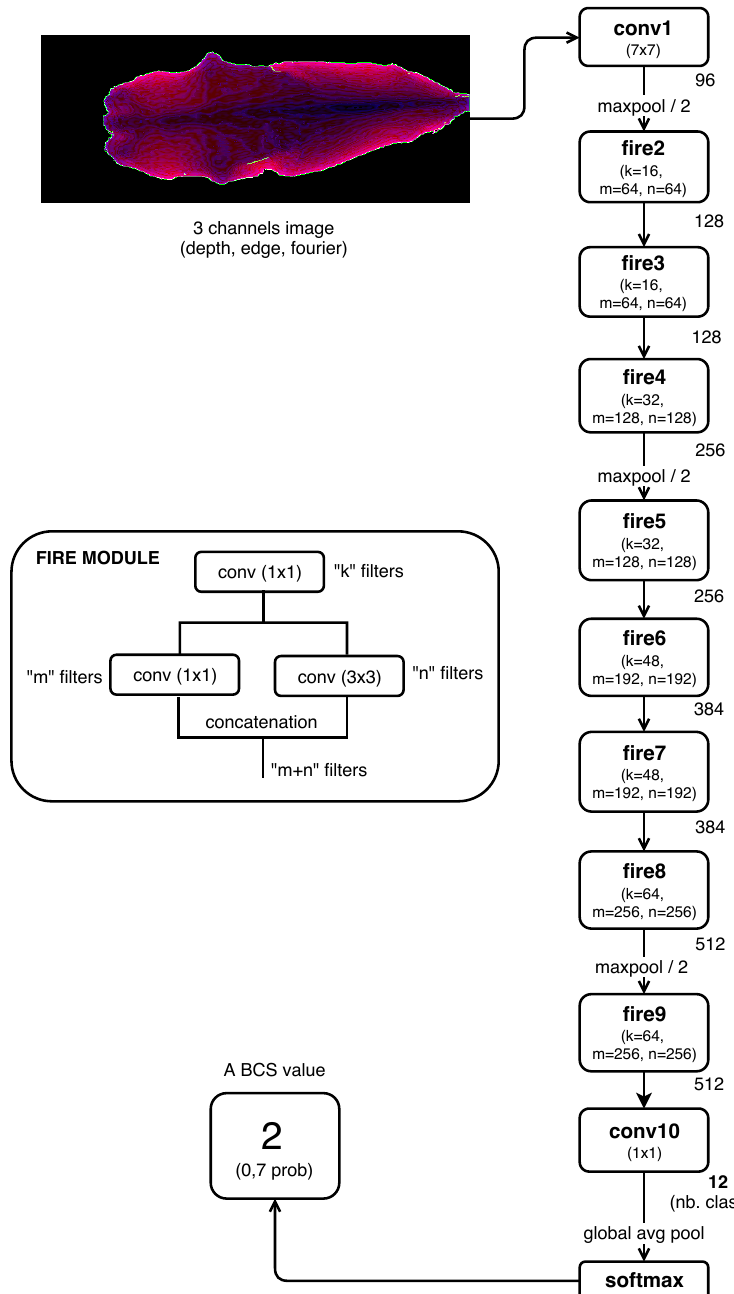
Figure 3. CNN architecture model implemented in previous work Rodríguez Alvarez et al. [15] (based on SqueezeNet [23]). Description of SqueezeNet “Fire” module, and structure of the CNN model from its input (preprocessed image) to the final predicted class or BCS value (class with highest probability according to the input